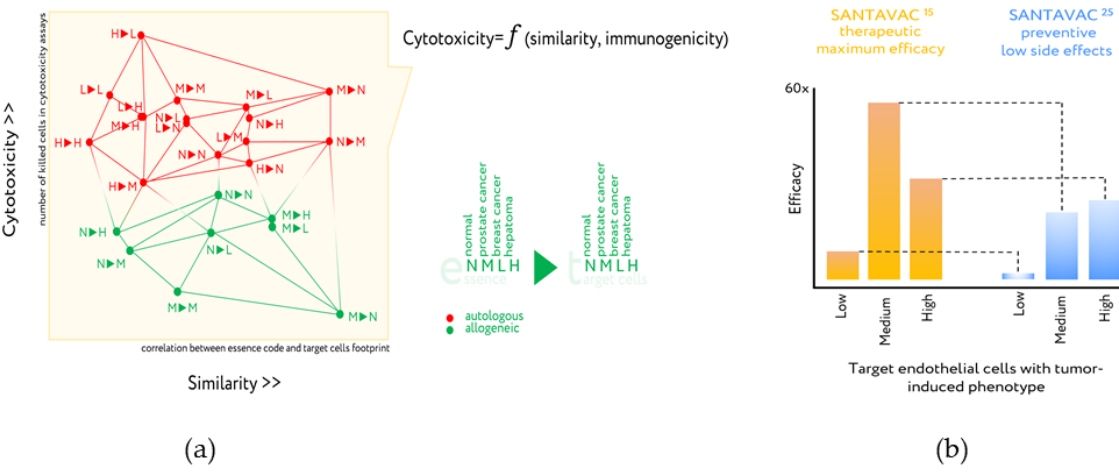
Figure 6. Design of antiangiogenic essence candidates based on comparison of essence code with target cell footprint and cytotoxicity assays. ( a ) Cytotoxicity is plotted vs. essence/target similarity as determined by correlation of essence composition with cell surface profile of target cells. Legend: 1 ► 2—First letter (1) corresponds to essence, second letter (2) corresponds to the target human microcirculatory endothelial cells (HMECs) used in the cytotoxicity assay. Letters are used to identify the presence in the growth medium of either normal EC growth supplement (N), MCF-7 cell-conditioned medium (M), LNCap cell-conditioned medium (L), or HepG2 cell-conditioned medium (H). All data in the plot were described by a set of linear functions from the essence/target similarity, in which the coefficients were also linearly interdependent and attributed to the essence immunogenicity. Adapted from [74,77]. ( b ) In vitro efficacy of optimized SANTAVAC compositions for final products. Target HMECs were incubated in the presence of effector CTLs at a 1:20 ratio. After 3 days, CTLs were removed and target cell viability was determined. Efficacy was calculated as a ratio of the number of tumor-stimulated cells in control (i.e., Low: HMEC 5% , Medium: HMEC 15% , or High: HMEC 25% ) to the number of tumor-stimulated cells in the experiment. Thus, efficacy predicts the therapeutic effect of the vaccine in vitro. For efficacy calculations, the data representing the mean value of three independent measurements were used. Percentage values indicated in the superscript correspond to the percentage of tumor-conditioned medium used to stimulate target HMEC, or HMEC used to generate SANTAVAC. SANTAVAC 15 corresponds to antigenic essence obtained from HMEC 15% . SANTAVAC 25 corresponds antigenic essence obtained from HMEC 25% . Adapted from [75].